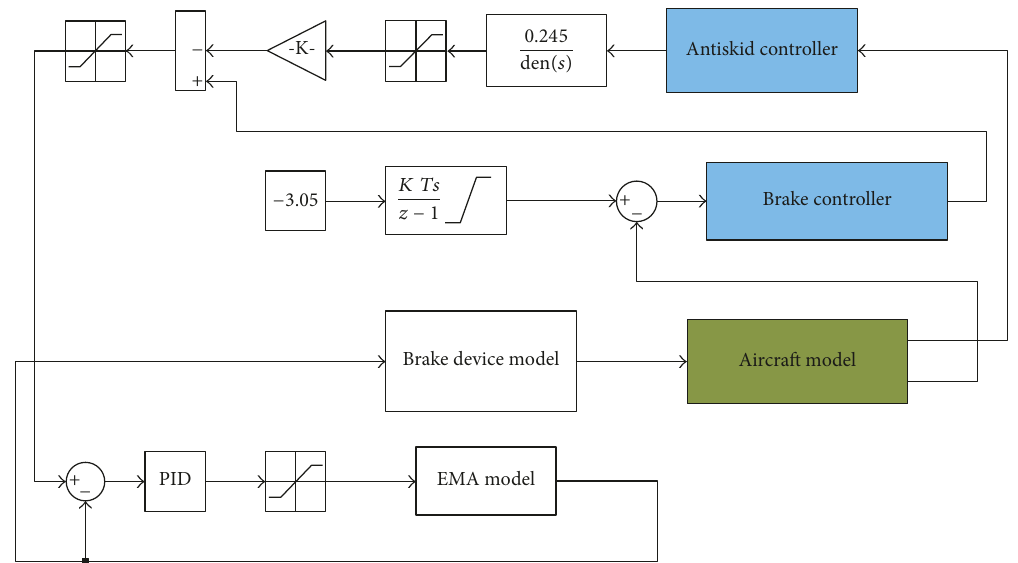
Figure 5: The integrated model of electric braking system.